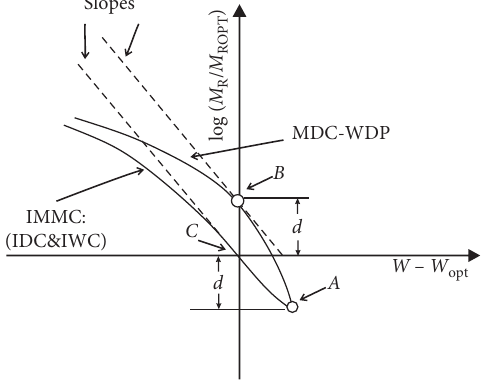
Figure 6: Illustration for predicting MWC-WDP (from